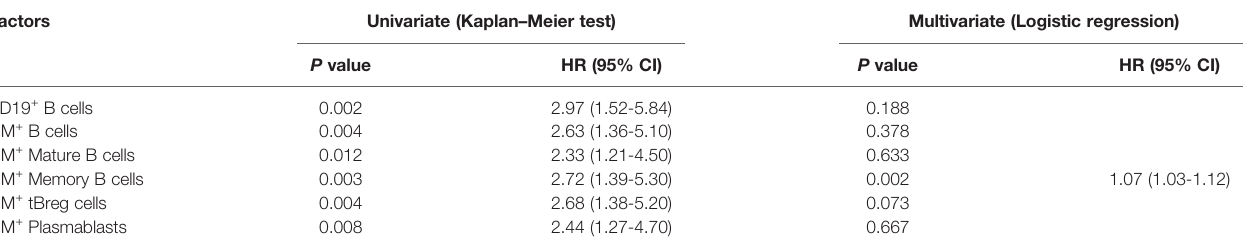
TABLE 2 | Univariate and multivariate logistic regression analyses of B cell signatures in the prediction of the responses to anti-PD-1 monotherapy. Factors Univariate (Kaplan – Meier